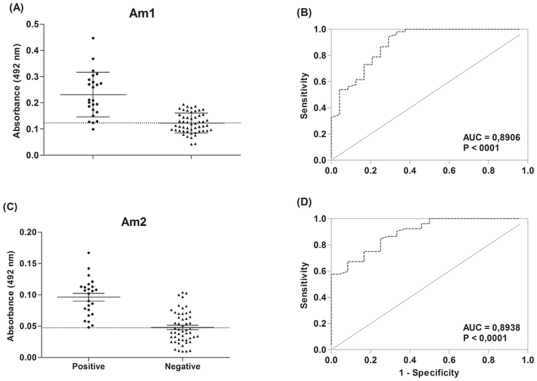
Antibody detection by ELISA.Detection of immunoglobulin G antibodies anti-Anaplasma marginale MSP1a in serum samples from infected and non-infected bovine with a definitive diagnosis of anaplasmosis (n = 24), and apparently healthy individuals (n = 52) by enzyme-linked immunosorbent assay using the Am1 (A) and Am2 (B), and the respectively ROC curve.